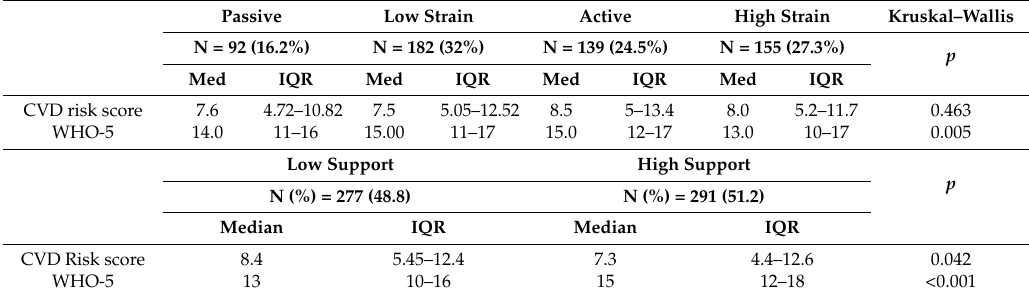
Table 4. Kruskal–Wallis test results comparing CVD risk, WHO-5 among Karasek’s categories and Job support categories (overall study